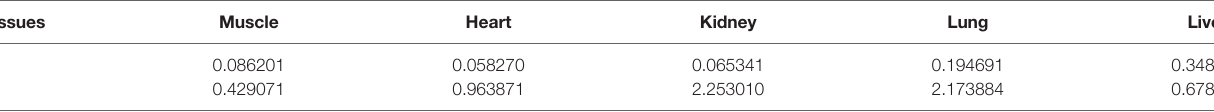
TABLE 1 | Optical parameters of different organs in the mouse model.